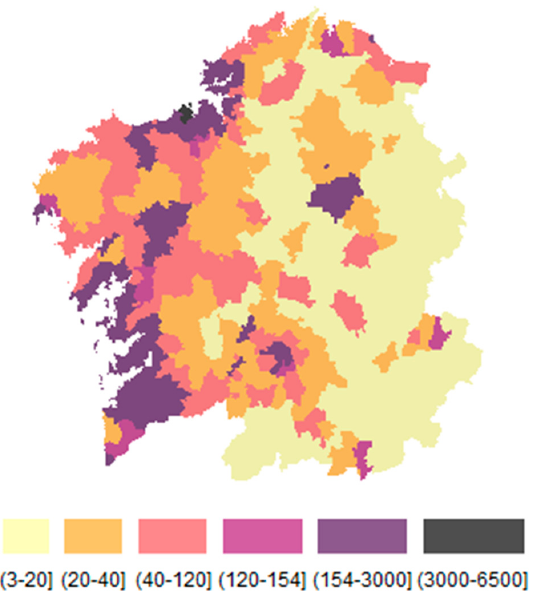
Figure 3. Population density. Information by municipalities (2020) (Inhabitants/Km 2 ). Source: National Statistics Institute.